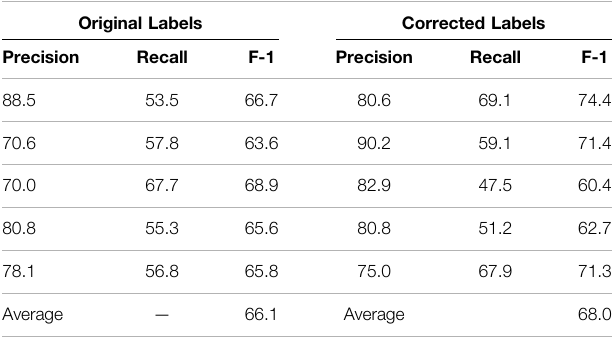
TABLE 2 | K-Fold (K (cid:1) 5) validation of the Keras-LSTM model on 96 paragraphs withoriginalvs.correctedlabels. The fi rst fi verowsaretheresultsofeachfold; the last row is the average F-1 score of the fi ve